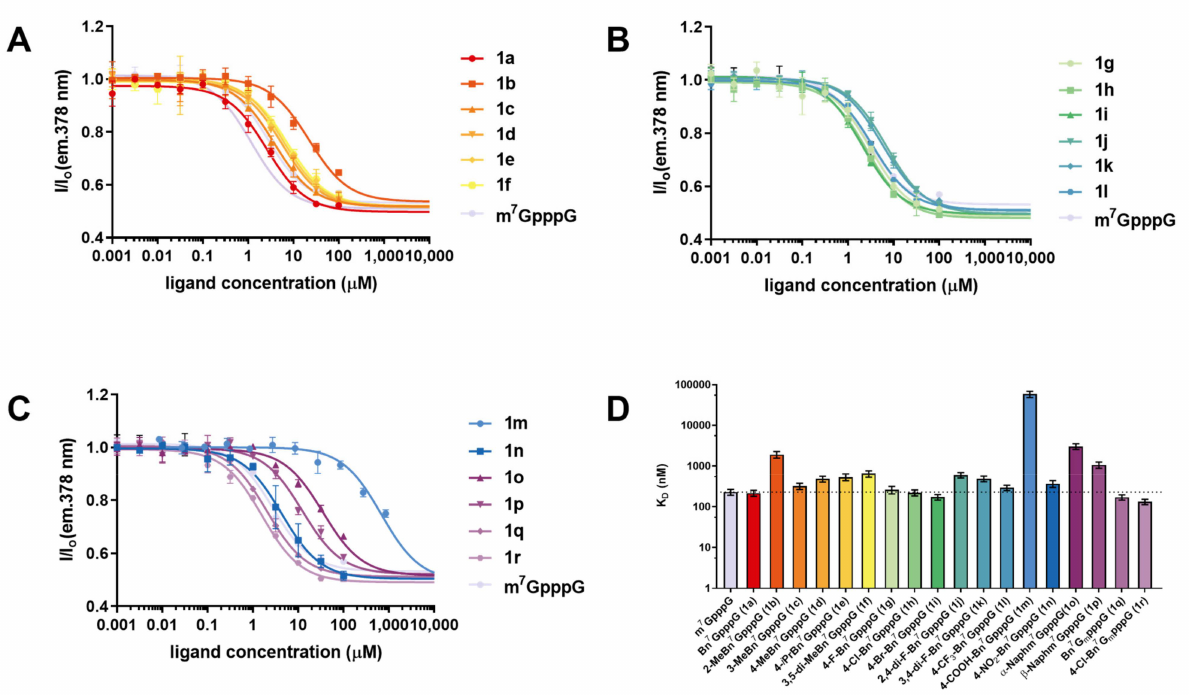
Figure 3. ( A – C ) Dose–response curves for N7-arylmethyl cap analogs and m 7 GpppG reference; ( D ) Comparison of the calculated K D values. Data are mean values ± SD from triplicate experiments. The K D values are summarized in Table 2. G m denotes 2 (cid:48) - O-